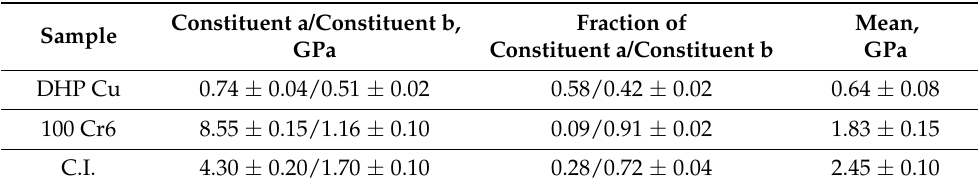
Table 2. Nanoindentation hardness at the different microstructure features of DHP Cu, 100 Cr6 steel, and grey cast iron (C.I.). Constituent a/constituent b are twined/untwined grains in DHP Cu, carbides/matrix in 100 Cr6, pearlite/ferrite in grey cast iron. Mean values are calculated as geometric average.